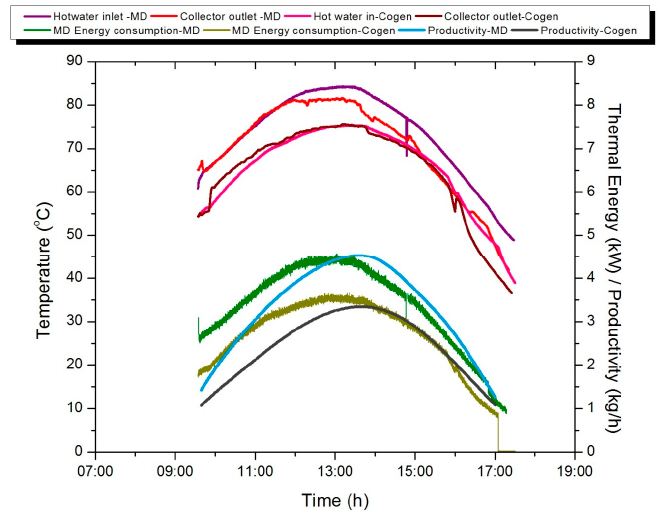
Figure 16. Comparison between standalone MD and co-generation.